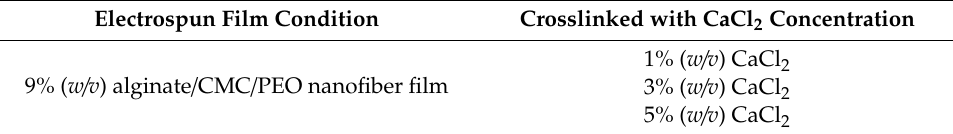
Table 3. Conditions of lidocaine-loaded alginate / CMC / PEO nanofiber films to confirm the lidocaine release